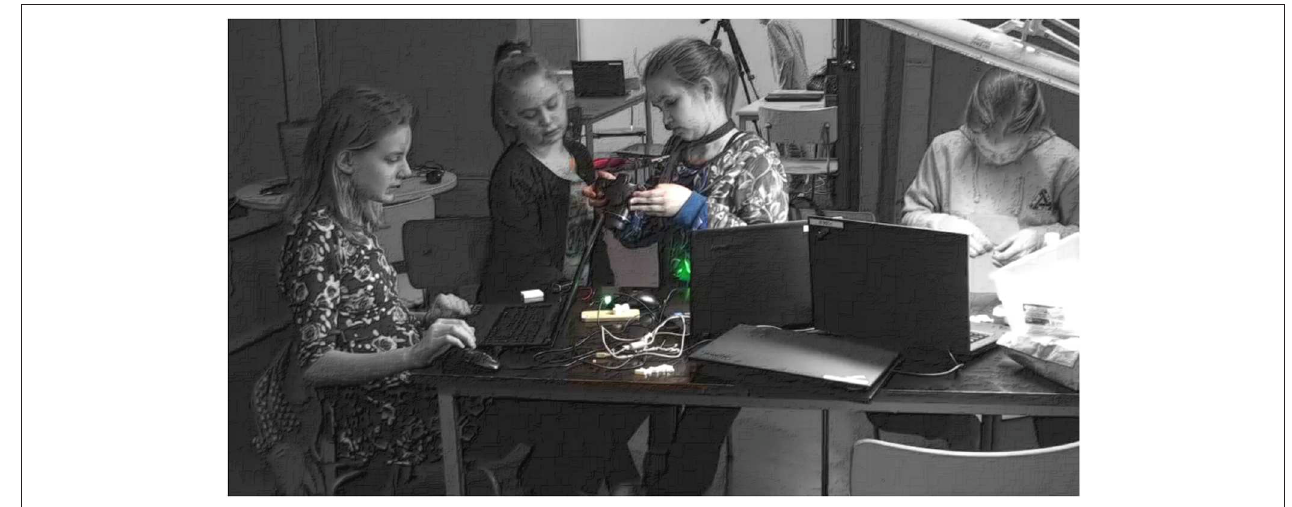
FIGURE 2 | Students working on the LED color lights design challenge.